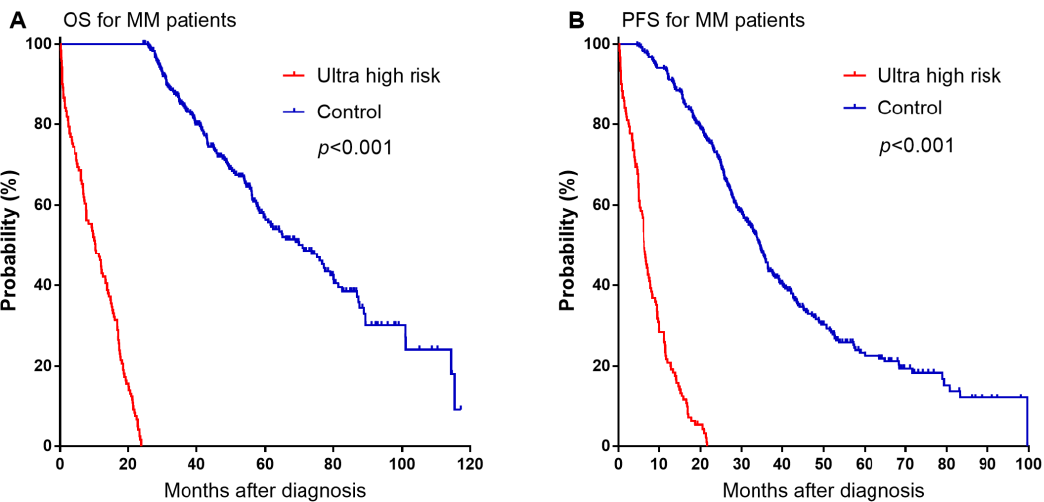
Figure 1. Kaplan-Meier survival curves on OS and PFS among patients with newly diagnosed MM. ( A ) OS. ( B ) PFS.